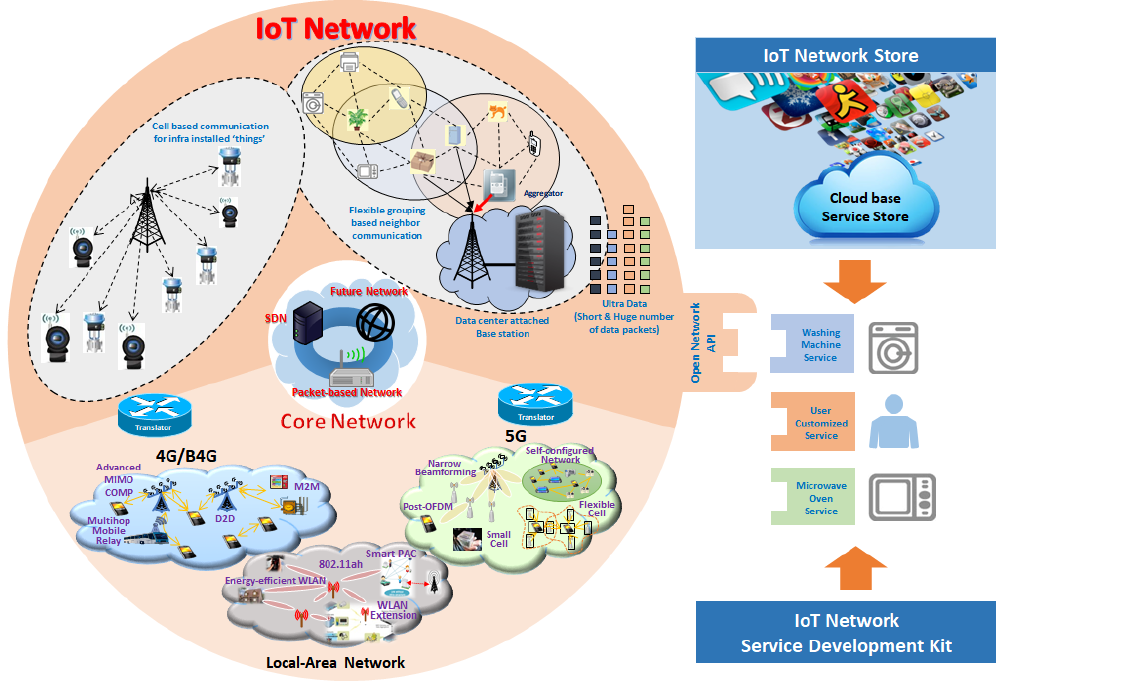
Figure 3. Overview of future IoT